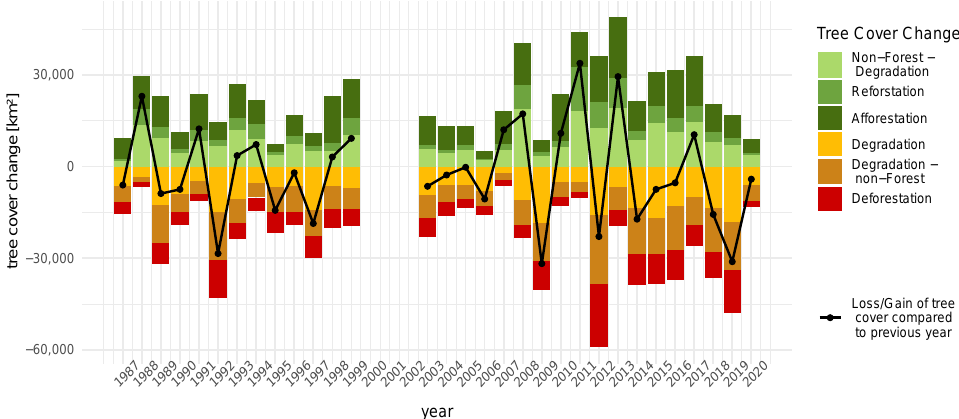
Figure 9. Tree cover changes per year (colored bars) and resulting yearly loss or gain of tree coverage (black